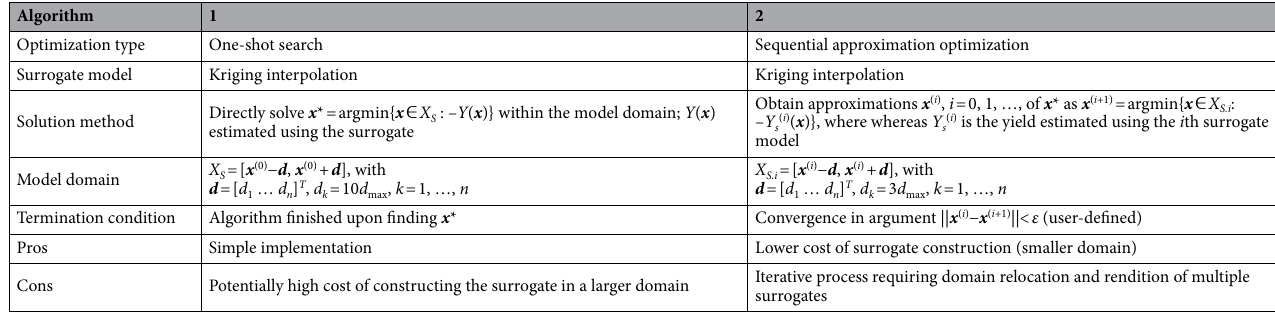
Table 1. Generic surrogate-assisted yield optimization algorithms (benchmark methods in section “Numerical verification”). #